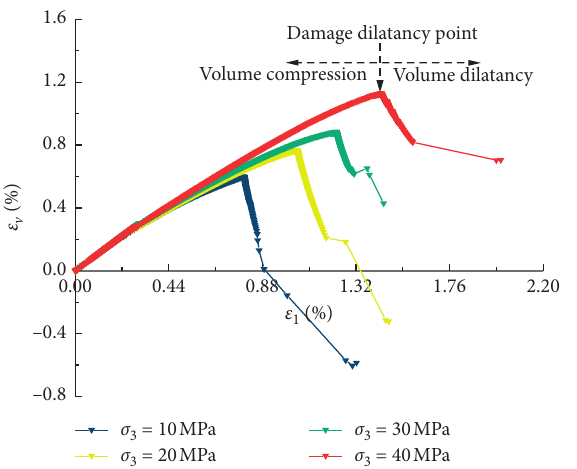
Figure 5: Axial strain-volume strain curve of sandstone under the unloading